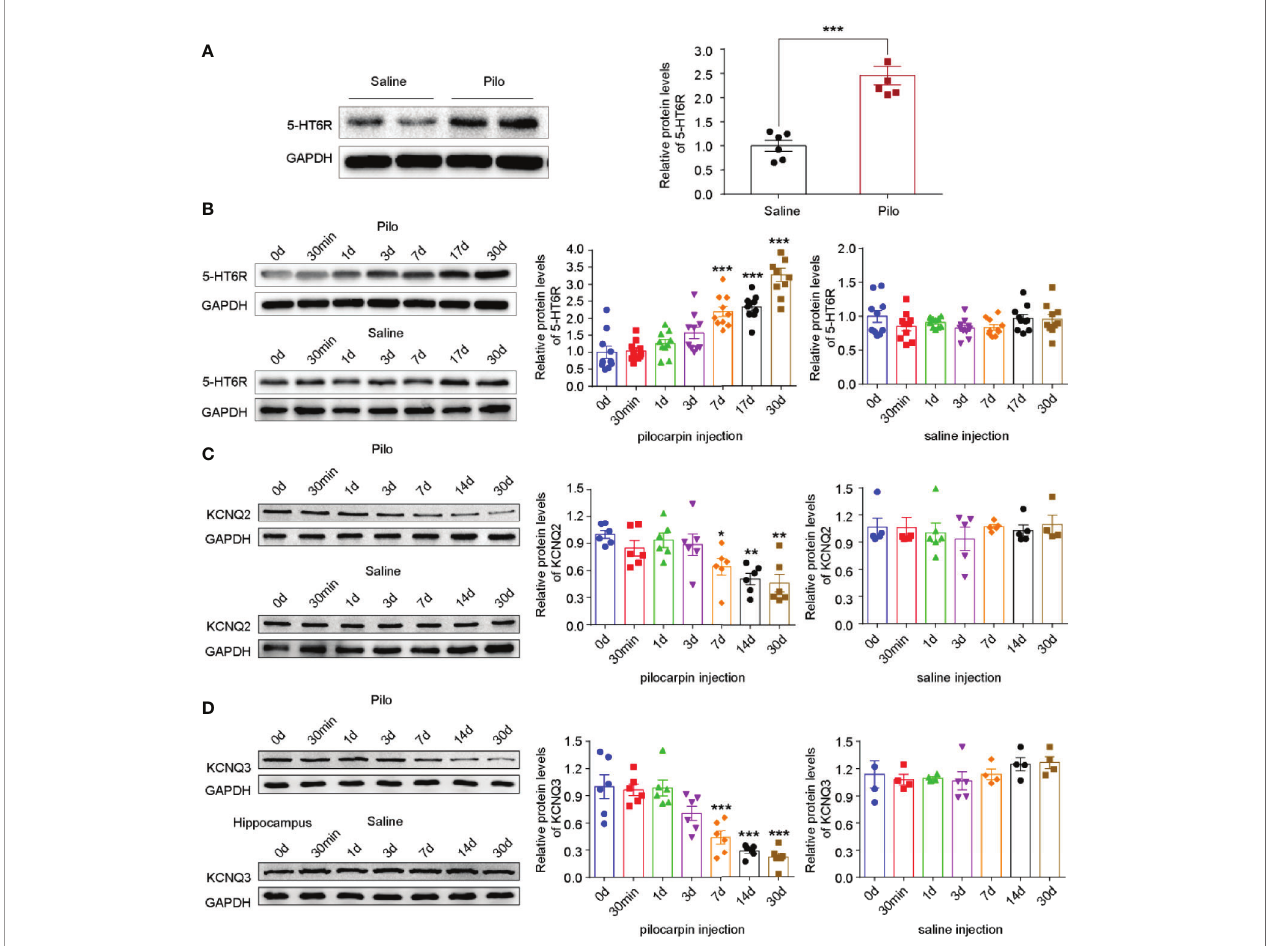
FIGURE 2 | Pilocarpine-induced SE differentially affects 5-HT6R and KNCQ2/3 expression levels in a time-dependant manner. (A) The expression of 5-HT6R in chronic epileptic rats. It was signi fi cantly increased in the hippocampus when compared with the Saline group (Saline group n= 4; Pilo group n= 4; t (10) = -6.424, p =0.0001). Statistical comparisons were analyzed by two-tailed unpaired Student's t-test (* p < 0.05, ** p < 0.01, *** p < 0.001). (B) The expression of 5-HT6R in the hippocampus after pilocarpine-kindled status epilepticus (SE). No change was evident across the timepoints after SE in the Saline group (n = 5 for each subgroup), while signi fi cant changes were observed in the Pilo subgroups (SE0d, SE30min, SE1d, SE3d, SE7d, SE14d, and SE30d), F (6,63) =30.753, p < 0.001). When compared with the baseline (before SE, SE0d), the expression of 5-HT6R increased notably in the SE7d, SE14d, and SE30d groups ( p < 0.001, p < 0.001, and p < 0.001, respectively). Statistical comparisons were performed with a one-way analysis of variance (ANOVA, p < 0.05) followed by the Bonferroni post-hoc test (* p < 0.05, ** p < 0.01, ** p < 0.001). (C) The expression of KCNQ2 in the hippocampus after pilocarpine-kindled status epilepticus (SE). Across the timepoints after SE, no change was evident in the Saline group (n = 5 for each sub-group), while signi fi cant changes were observed in the Pilo subgroups (SE0d, SE30min, SE1d, SE3d, SE7d, SE14d, and SE30d), F (6,35) =7.426, p < 0.001). When compared with the baseline (before SE, SE0d), the expression of KCNQ2 increased notably in the SE7d, SE14d, and SE28d groups ( p = 0.0258, p = 0.0019, and p = 0.0010, respectively). Statistical comparisons were performed with one-way analysis of variance (ANOVA, p < 0.05) followed by the Bonferroni post-hoc test (*: p < 0.05, ** p < 0.01, *** p < 0.001). (D) The expression of KCNQ3 in the hippocampus after pilocarpine-kindled status epilepticus (SE). Across the timepoints after SE, no change was evident in the Saline group (n = 5 for each sub-group), while signi fi cant changes were observed in the Pilo subgroups (SE0d, SE30min, SE1d, SE3d, SE7d, SE14d, and SE30d), F (6,35) =18.793, p < 0.001);. When compared with the baseline (before SE, SE0d), the expression of KCNQ3 increased notably in the SE7d, SE14d, and SE28d groups ( p =0.0003, p < 0.001, and p < 0.001, respectively). Statistical comparisons were performed with one-way analysis of variance (ANOVA, p < 0.05) followed by the Bonferroni post-hoc test (* p < 0.05, ** p < 0.01, *** p <